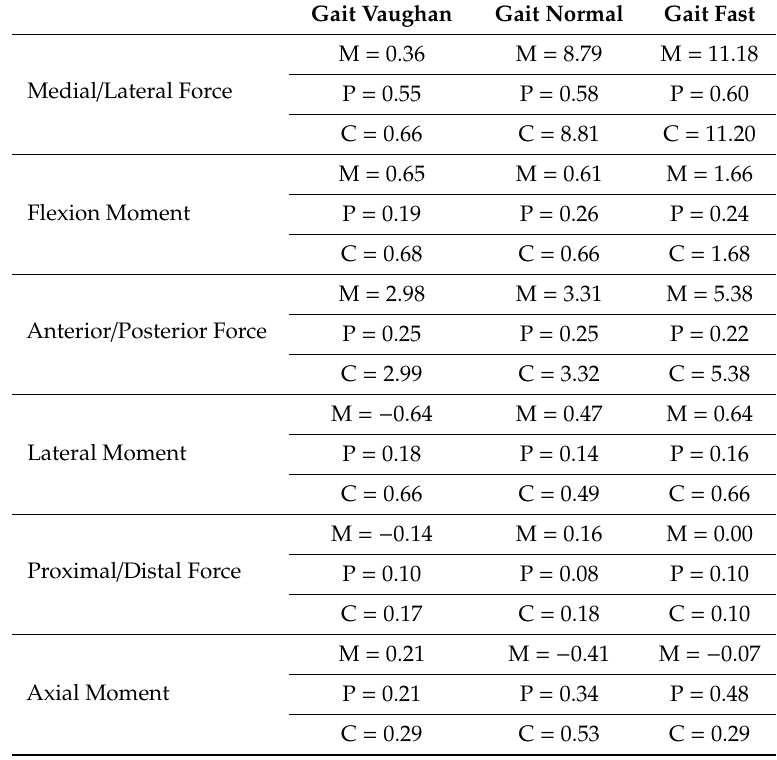
Table 2. Geers metric applied for force and moment components. in silico vs. in vivo.